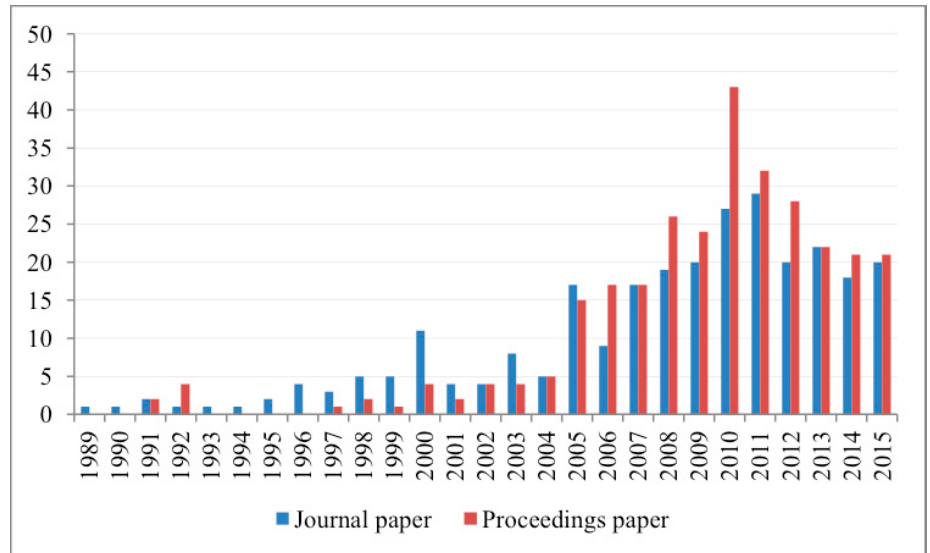
Figure 1. Occurrence of document types per year of publication.